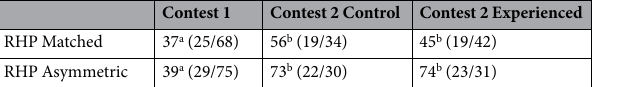
Table 2. Non-escalation. Values are the percentage of contests that reached an outcome (clear winner) without fighting. The number of contests out of which the percentage is calculated is presented in parentheses. a,b Values lacking a common superscript letter differ by P <